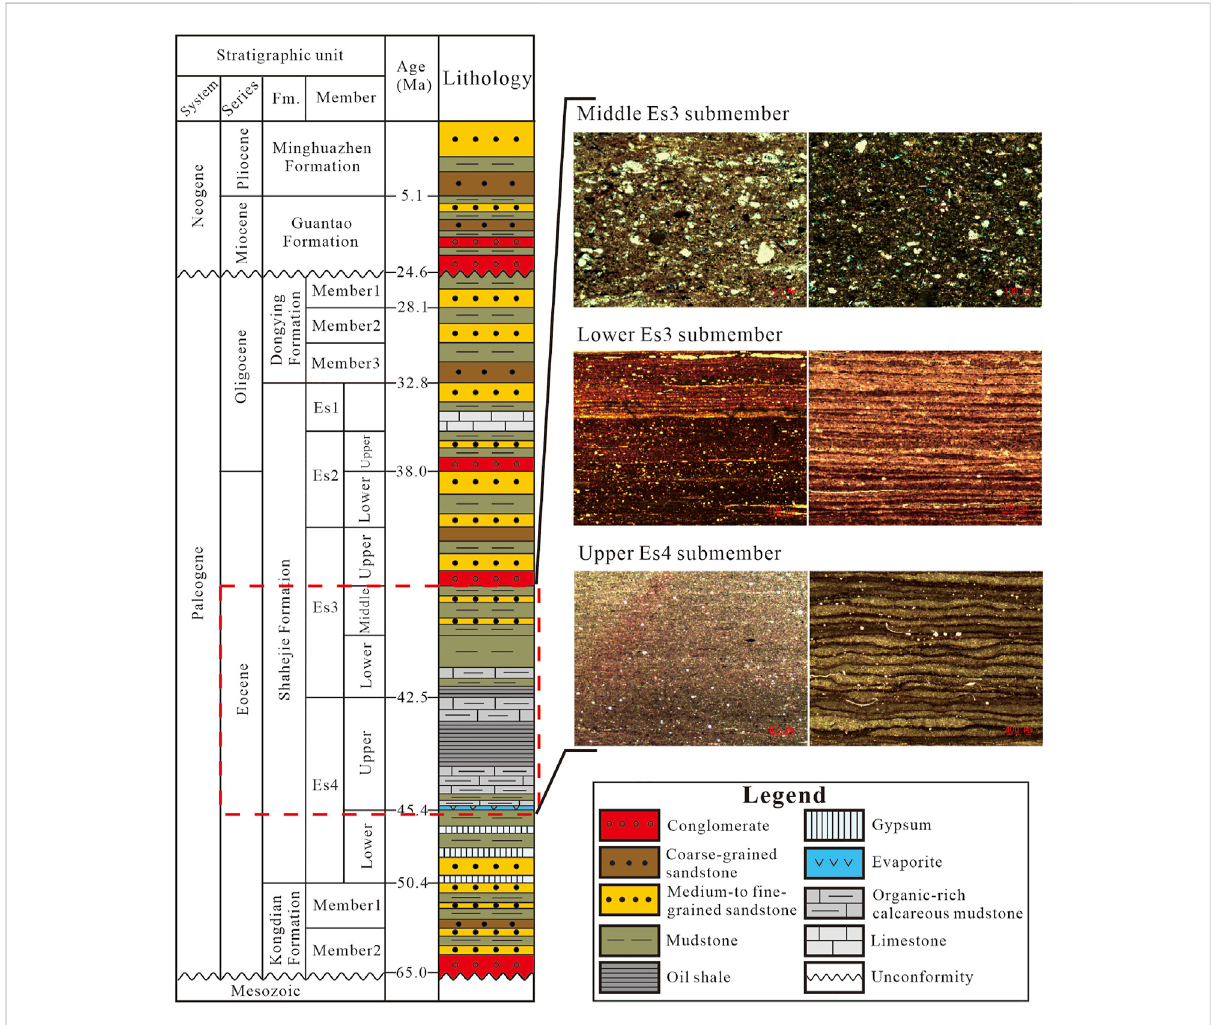
FIGURE 2 Stratigraphic column of the Dongying Sag (Modi fi ed from Ma et al.,